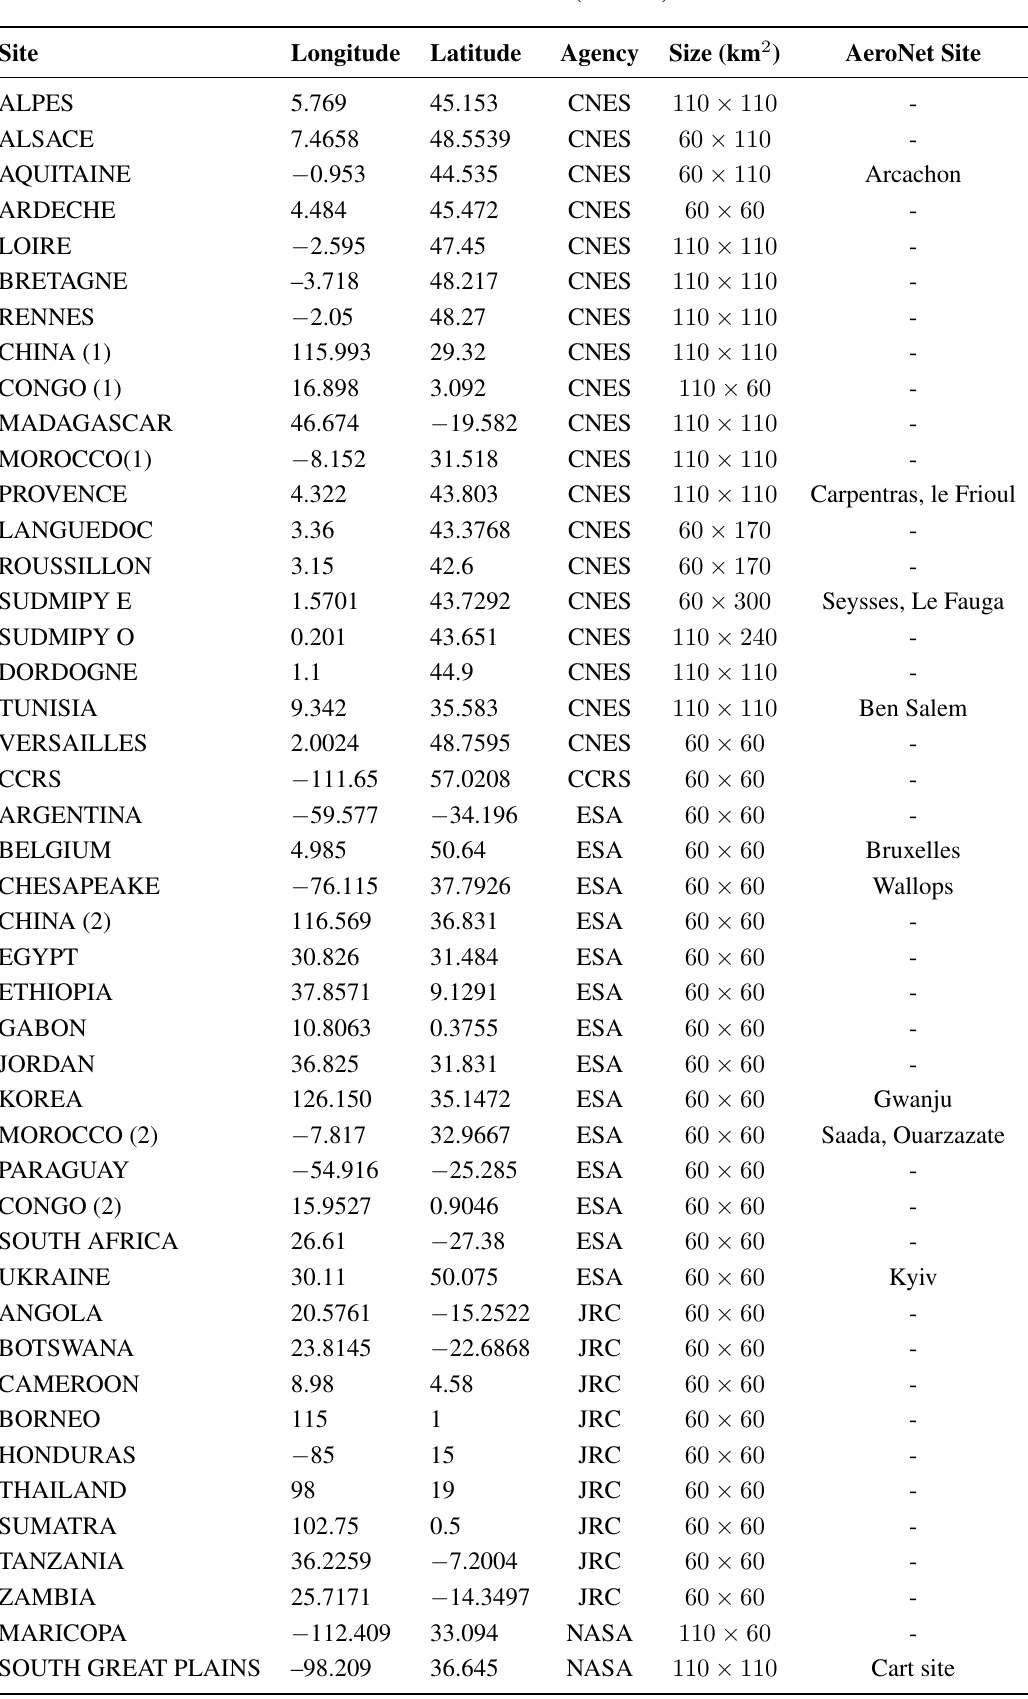
Table 1. List of SPOT-4 (Take 5)